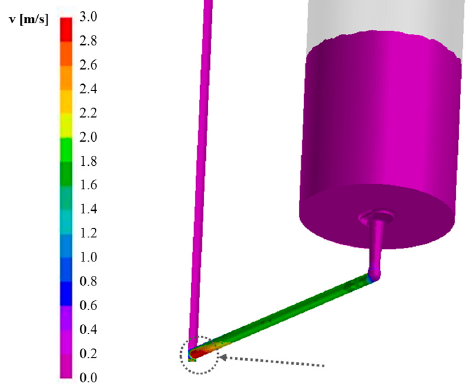
Figure 11. Shear velocity in the horizontal runner.